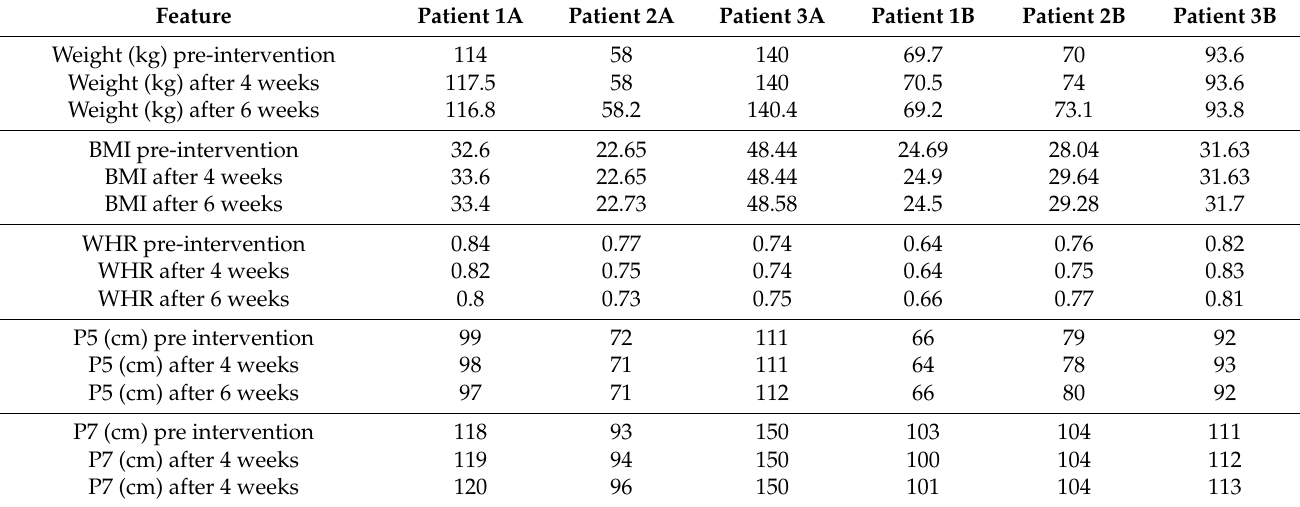
Table 2. BMI, WHR, weight (kg), and circumference (cm) among all patients pre- intervention, after 4 weeks, and after 6